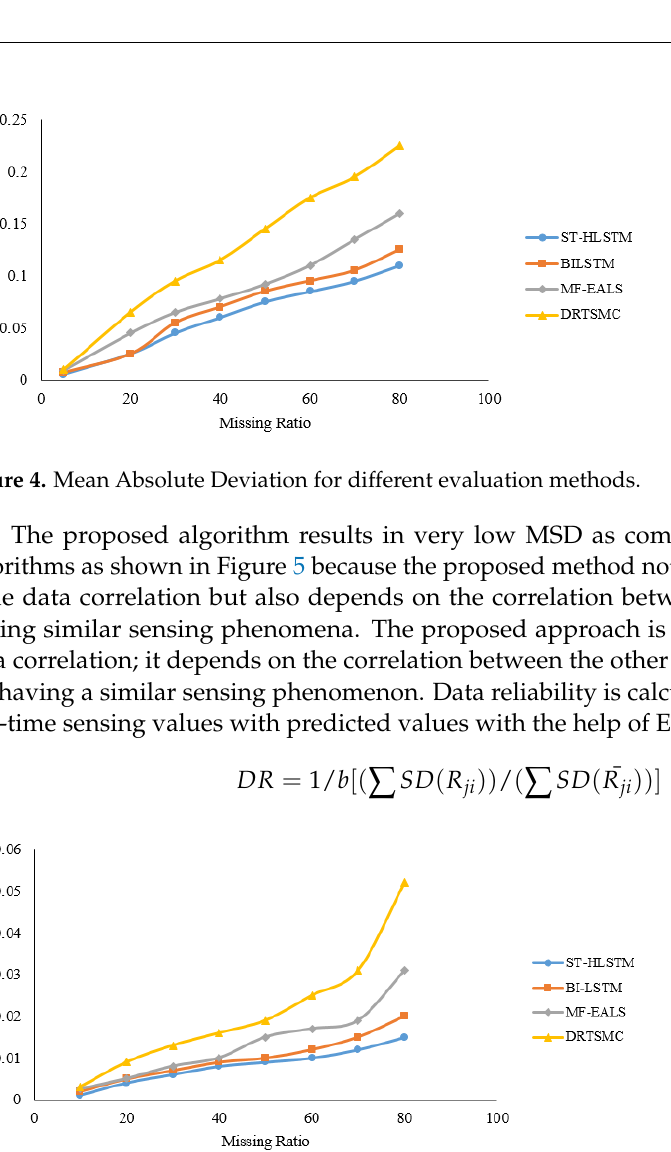
Figure 5. Mean Squared Deviation for various evaluation methods.